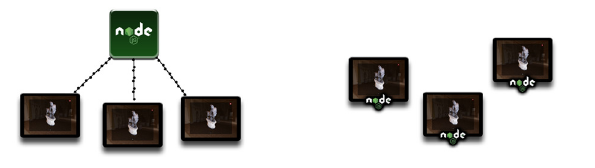
Figure 8. Centralized and decentralized approaches.